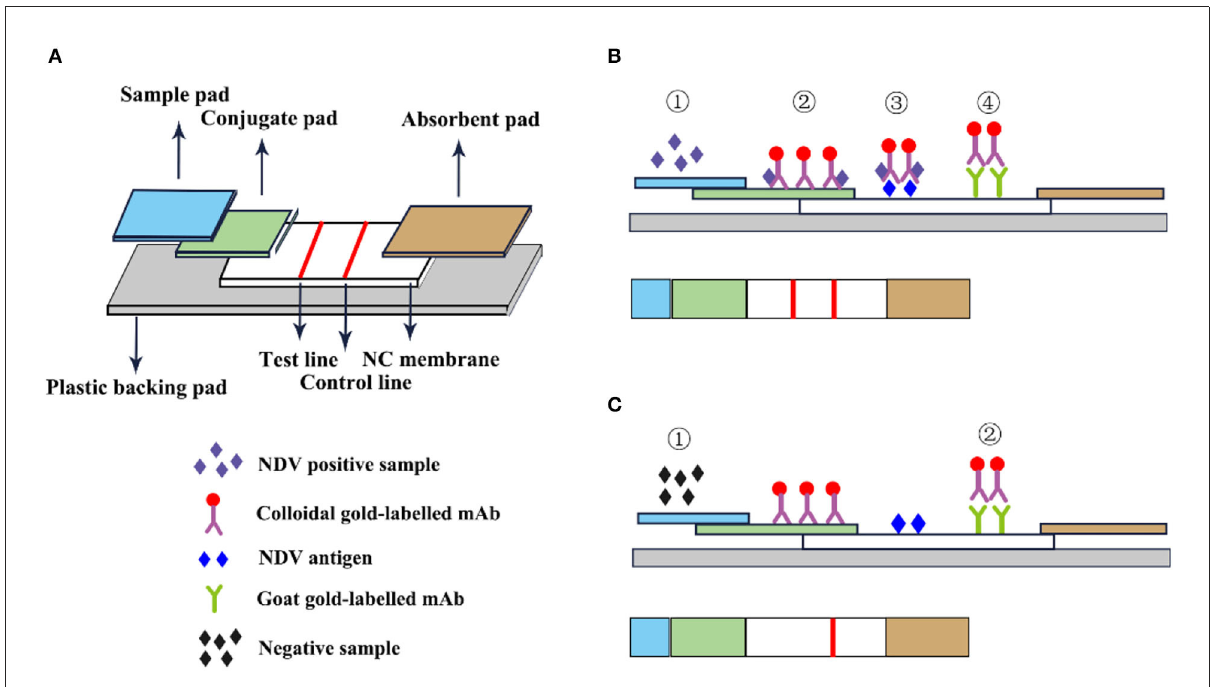
FIGURE8 Schematic diagram of immunocolloidal gold. (A) Immunocolloidal gold components; (B) NDV positive control; (C) Negative control.